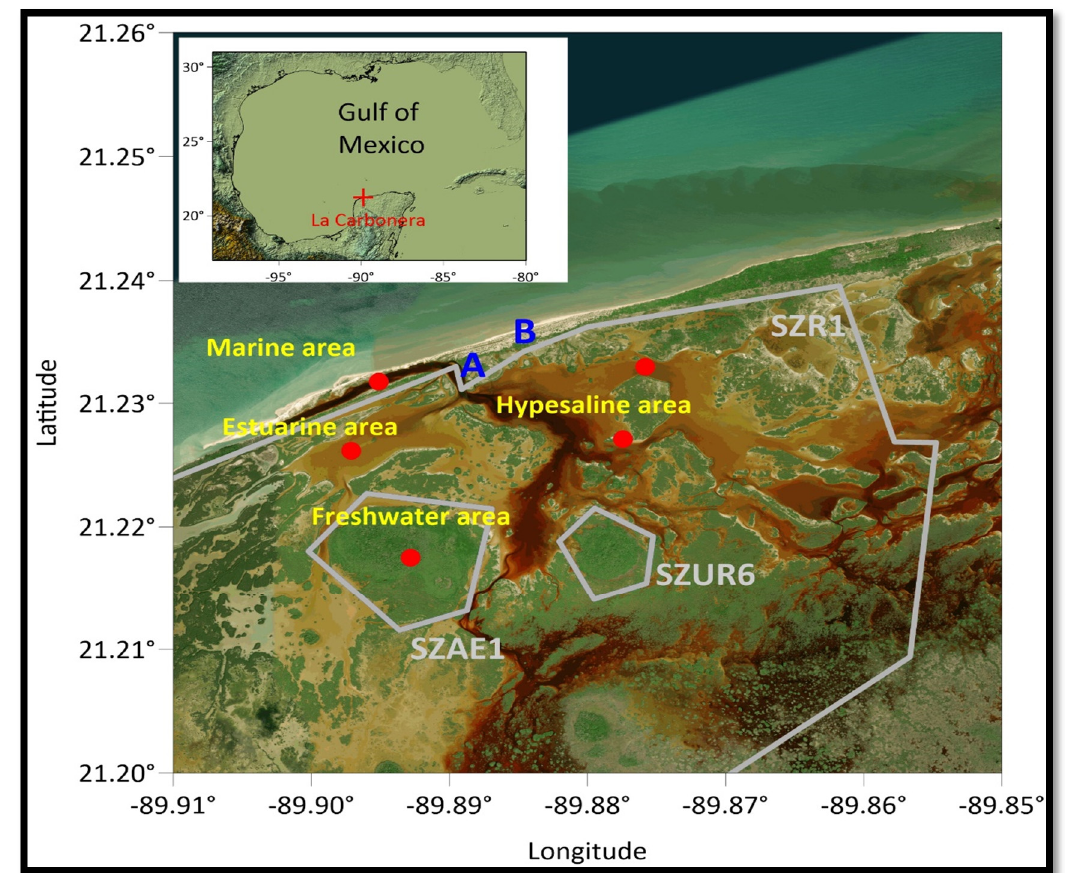
Figure 1. Location of La Carbonera lagoon, Yucatan, Mexico, showing areas with significant saline properties, the location of the CTD sensors (red dots), and sites proposed for the RED power plant (A and B). The polygons SZR1, SZAE1, and SZUR6 are areas with protection categories within the Cienegas and Manglares State Reserve of the North Coast of Yucatán (RECMY).